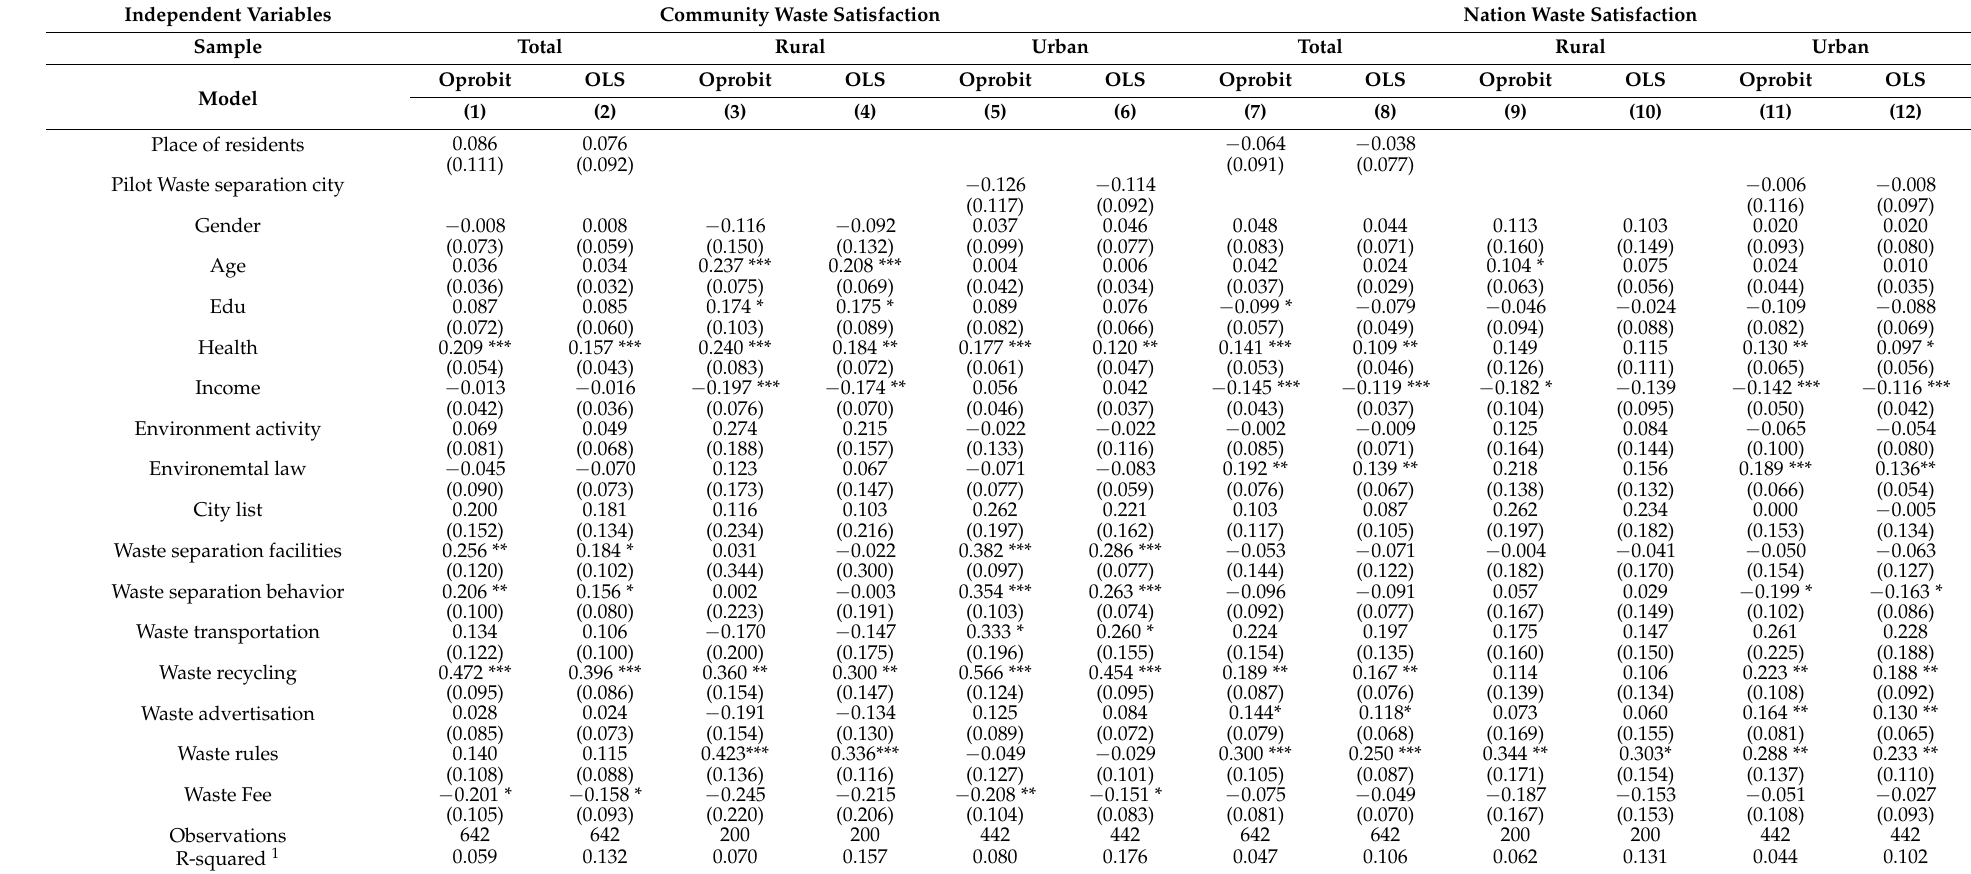
Table A3. Satisfaction with communities and national solid waste management services in